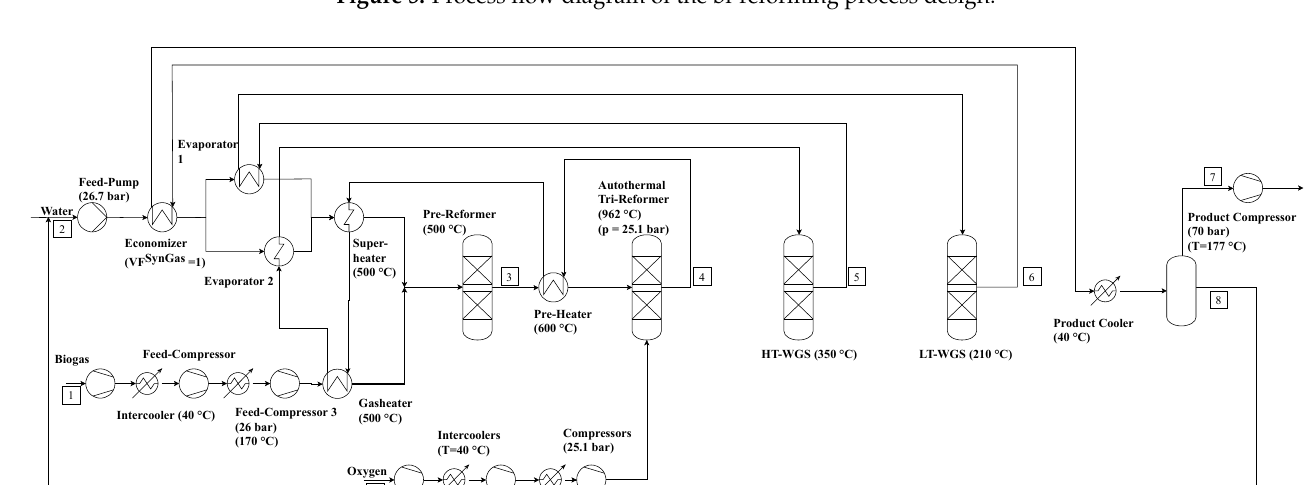
Figure 6. Process flow diagram of the tri-reforming process (Stream details for flows 1–9 in Appendix E).